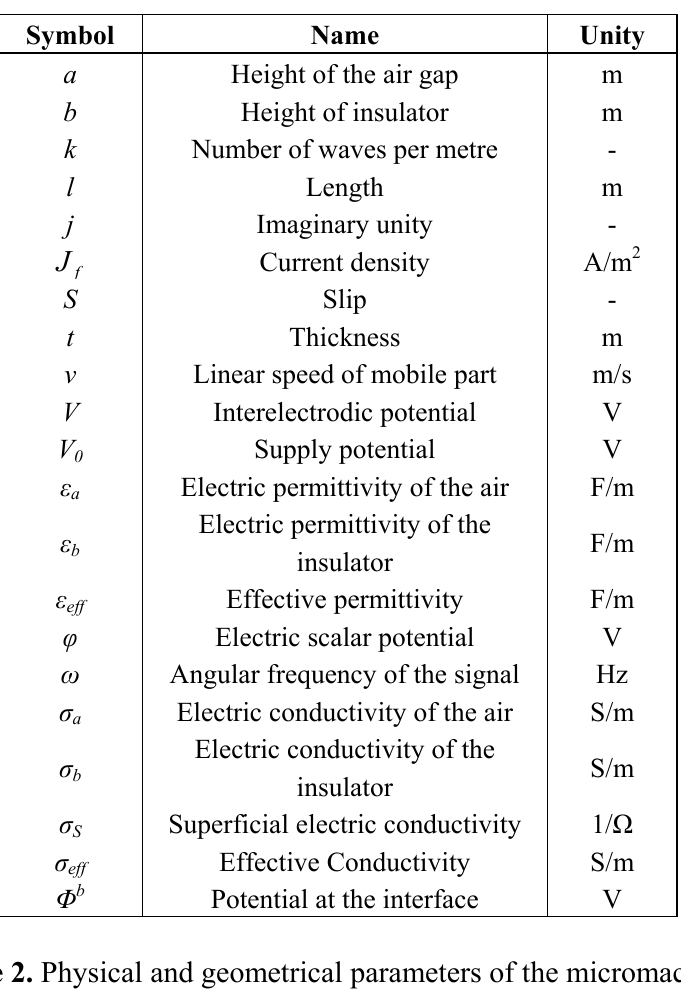
Table 1. Nomenclature.